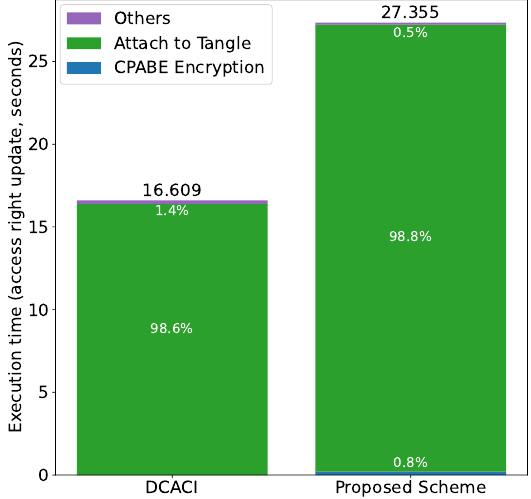
Figure 24. Comparison with DCACI: access right update.